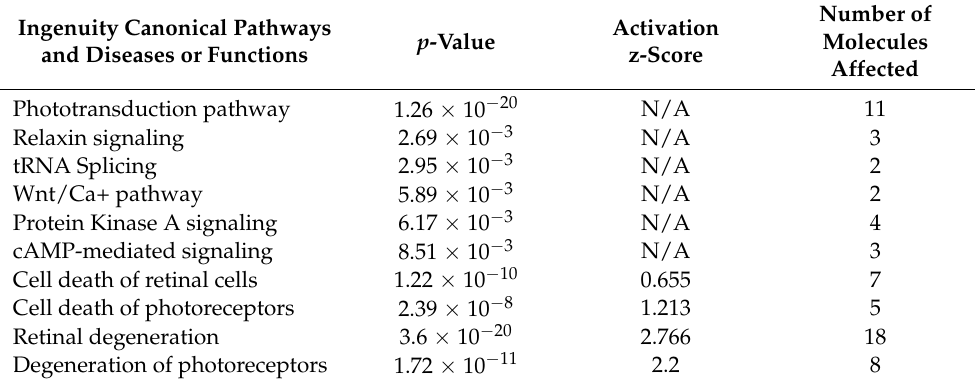
Table 7. Infected eyes with severe retinal degeneration vs. infected eyes without severe retinal de- generation.